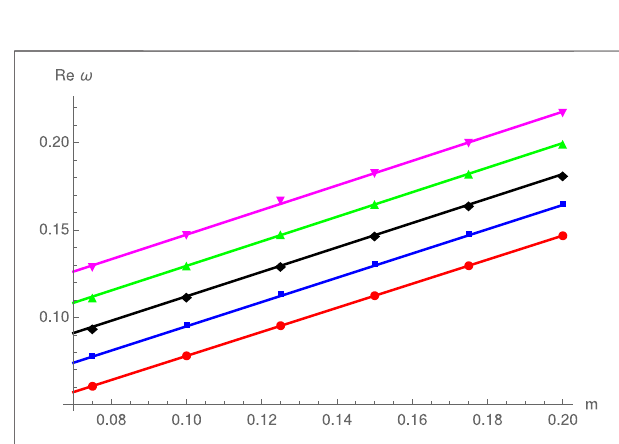
FIGURE3| Forthe fi rstfiveQNFsoftheKlein-Gordon fi eldweshowhow the realpartdependson themassofthe fi eld. Weconsider a2Dblack hole(2) of radius r + (cid:1) 70.